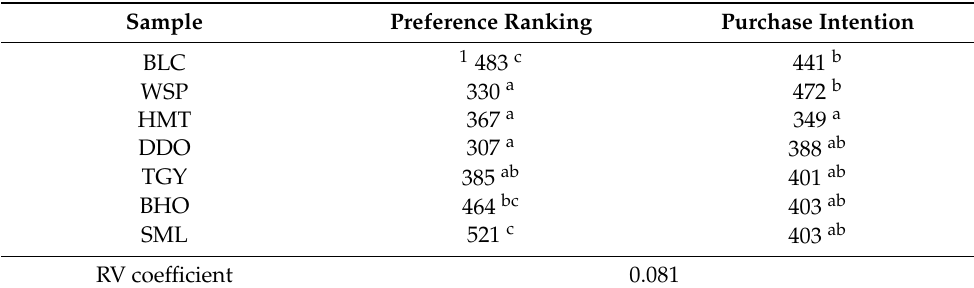
Table 3. Preference ranking versus purchase intention for the cold infusions of these seven Taiwanese specialty